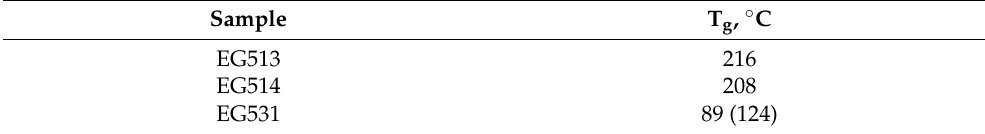
Table 2. T g of cured samples due to the DSC analysis.